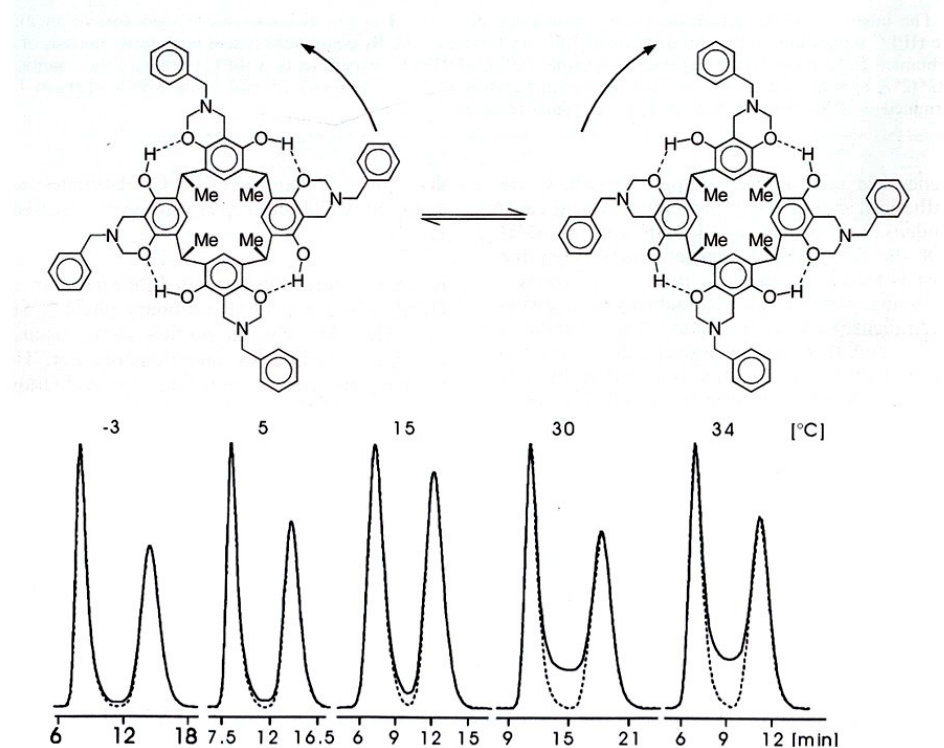
Figure 33. Top : Interconverting enantiomers of tetrabenzoxacine resorc[4]arene by HPLC on the CSP Chiralpak AD. Bottom : Distorted peak profiles caused by enantiomerization (dotted line: expected peak profiles devoid of interconversion). Reprinted with permission from [127].